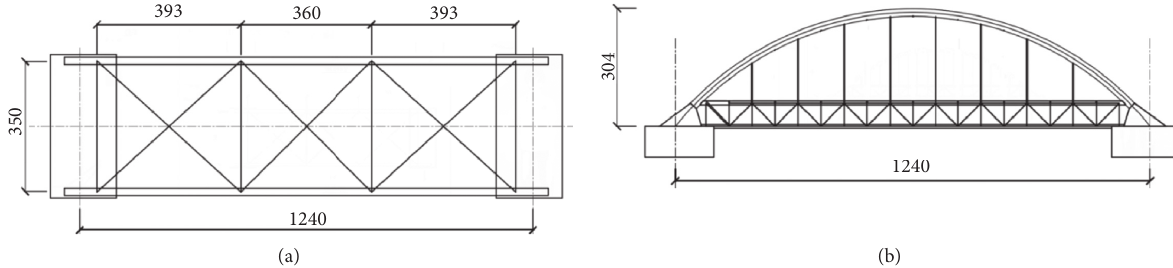
Figure 3: Model structure of steel arch bridge: (a) plan view of the steel arch bridge model (1 :100); (b) elevation view of the steel arch bridge model (1:100).